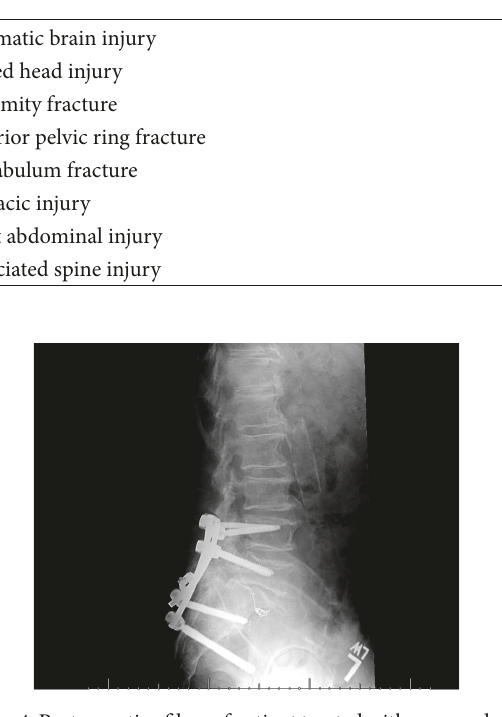
Figure 4: Postoperative films of patient treated with open reduction internal fixation of spinopelvic